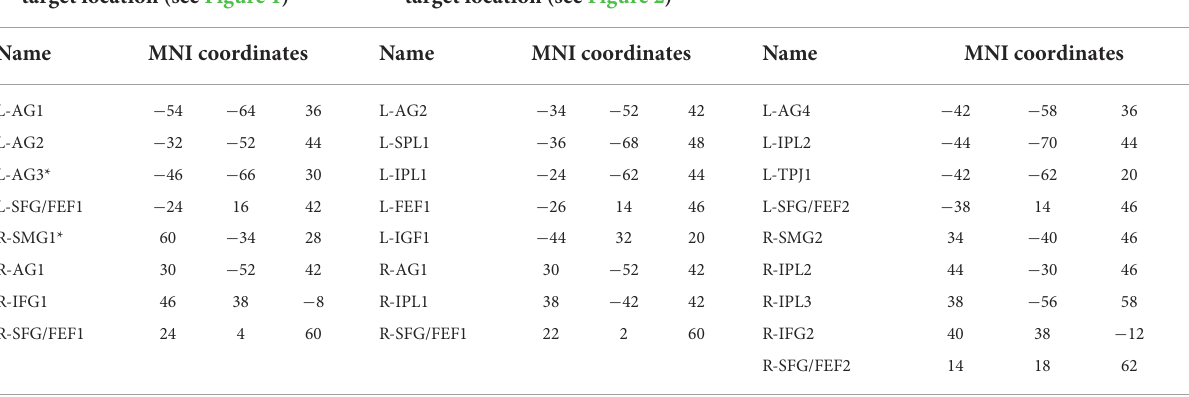
TABLE 3 Names and peak localisations of the parietal and prefrontal regions of interest extracted from the activations shown in Figure 1A (3 groups), Figure 2A (groups RWRH and RWLH), and Figure 3A (groups RWRH and LWRH) and used in the measures of percent signal changes shown in Figures 1C, 2C, 3C,